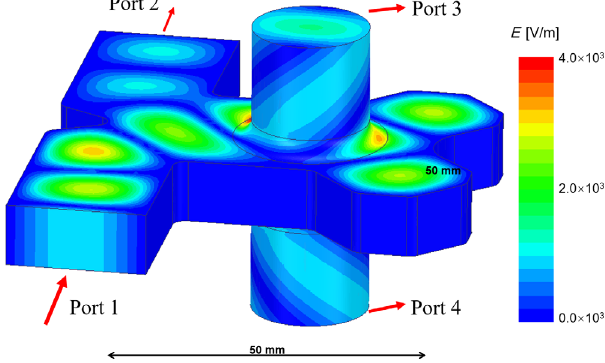
FIG. 1. Vacuum model of the X -band two-stage pulse com- pression system.